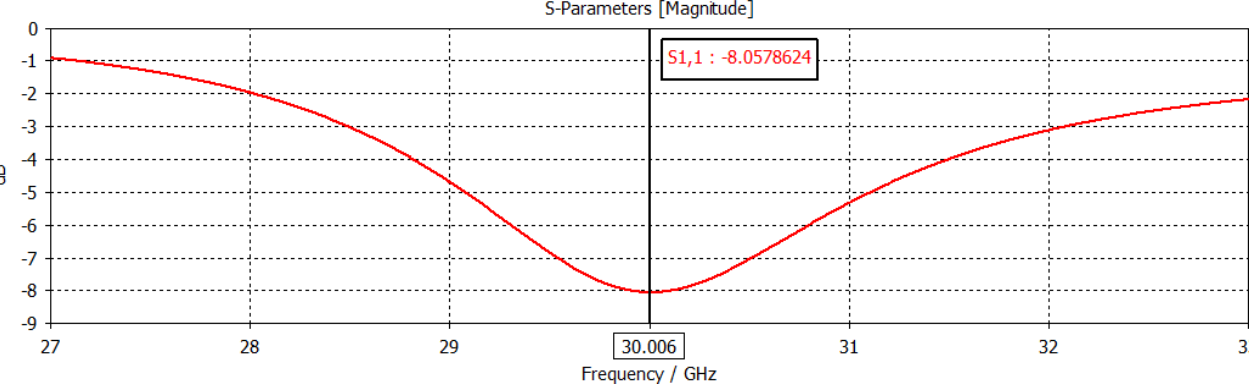
Figure 6. Reflection Coefficient (S11)